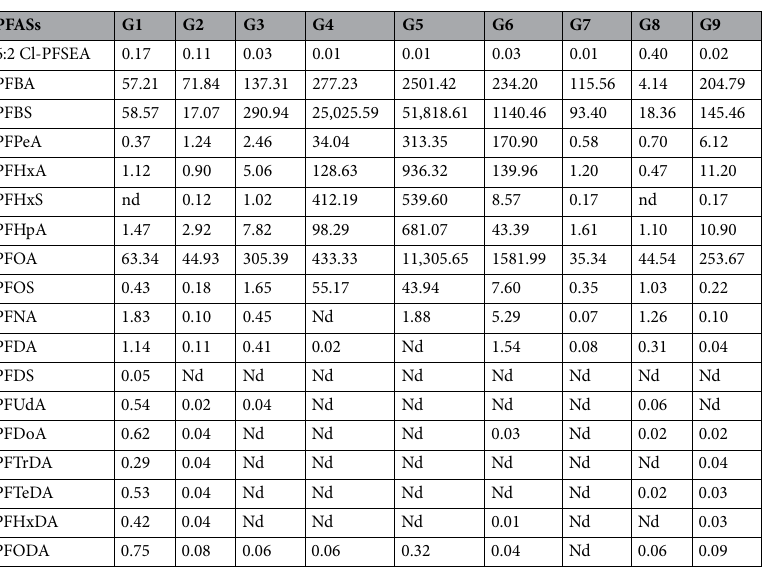
Table 2. PFASs concentrations in groundwater (ng·L −1 ) from the FCP of Fuxin, China. Nd not